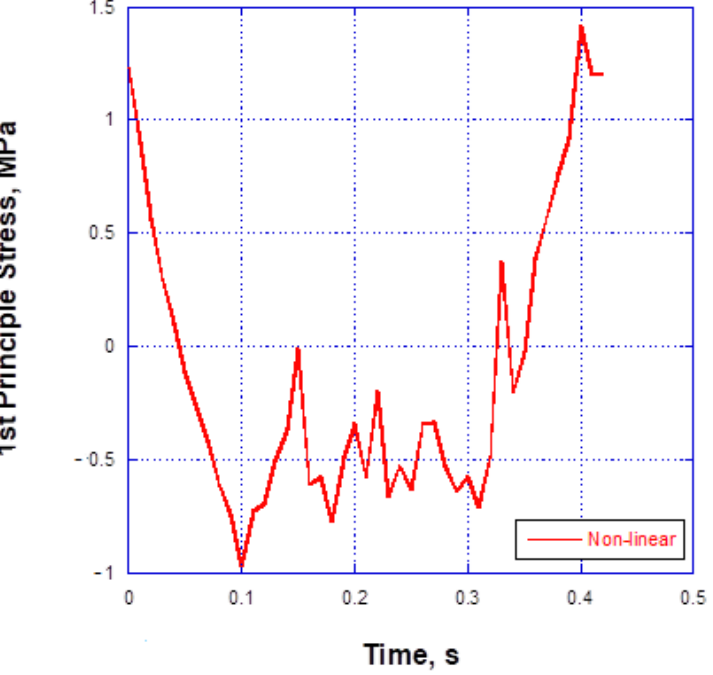
Figure 7. Plot of 1st principal stress vs. time at commissure point in the present study.